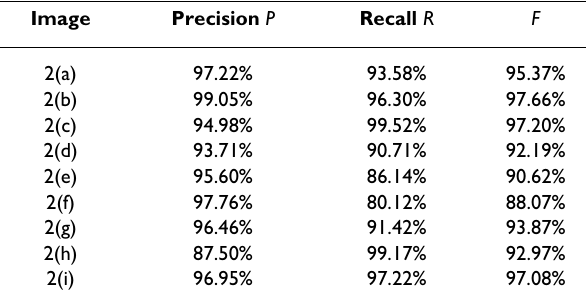
Table 2: Analysis of the segmentation performance Image Precision P